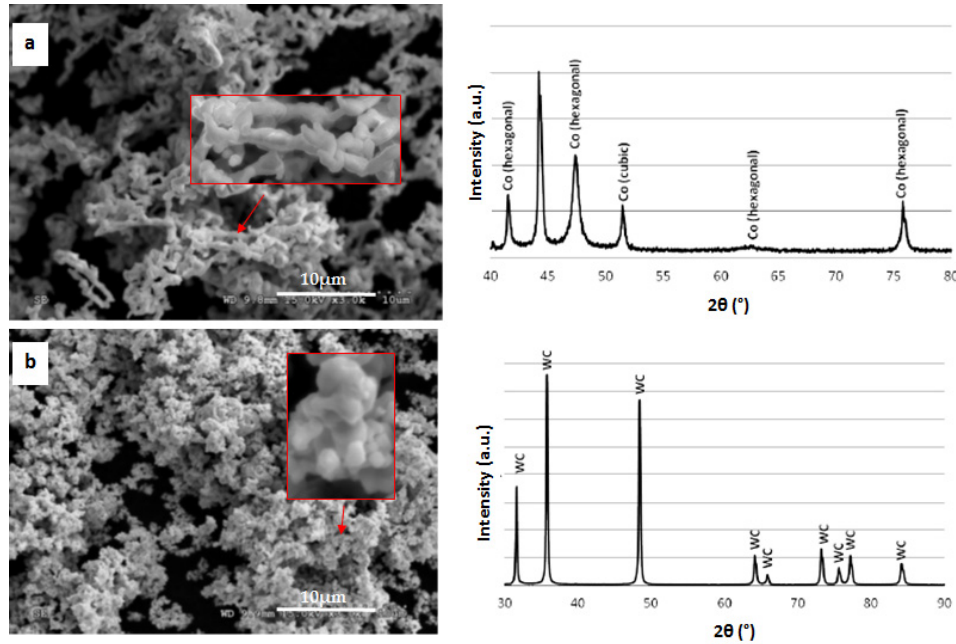
Figure 1. SEM image and XRD analysis: ( a ) cobalt powder, ( b ) WC powder.